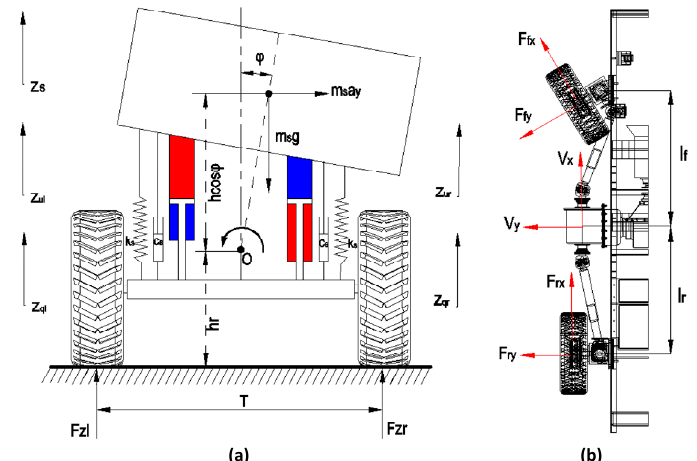
Figure 1. Schematic of a six-degrees-of-freedom (6-DOF) rescue vehicle model: ( a ) the 4-DOF roll motion model; ( b ) the 2-DOF steer-yaw model.